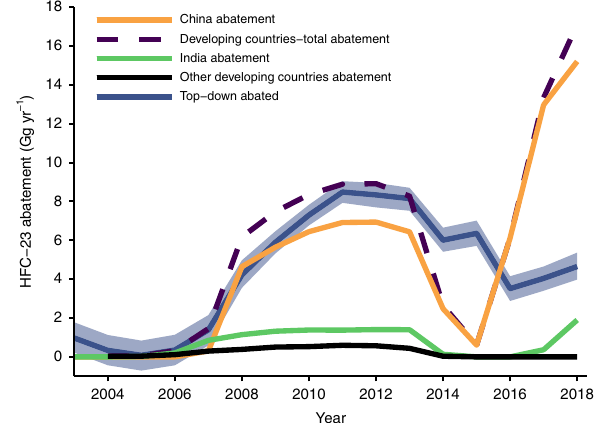
Fig. 3 Reported abatement versus estimates based on atmospheric data. Total developing countries HFC-23 abatement (blue line, with blue shaded area showing 1 σ uncertainty) calculated from the developing country no abatement bottom-up emissions estimates minus the top-down emissions derived from the 12-box model with developed world reported emissions removed. Chinese (orange line) and Indian (green line) abatement are compiled from the United Nations Framework Convention on Climate Change ʼ s Clean Development Mechanism (CDM) reports (2010 – 2014), Chinese hydrochloro fl uorocarbons production phase-out management plan (HPPMP) reported emission reductions, and the Indian executive order to abate all HFC-23 emissions from 13 October 2016. Other developing country abatement as part of the CDM is shown in the black line. Developing countries-total abatement (dashed purple line) shows the summation of all developing country abatement as part of the CDM, Chinese HPPMP and Indian executive